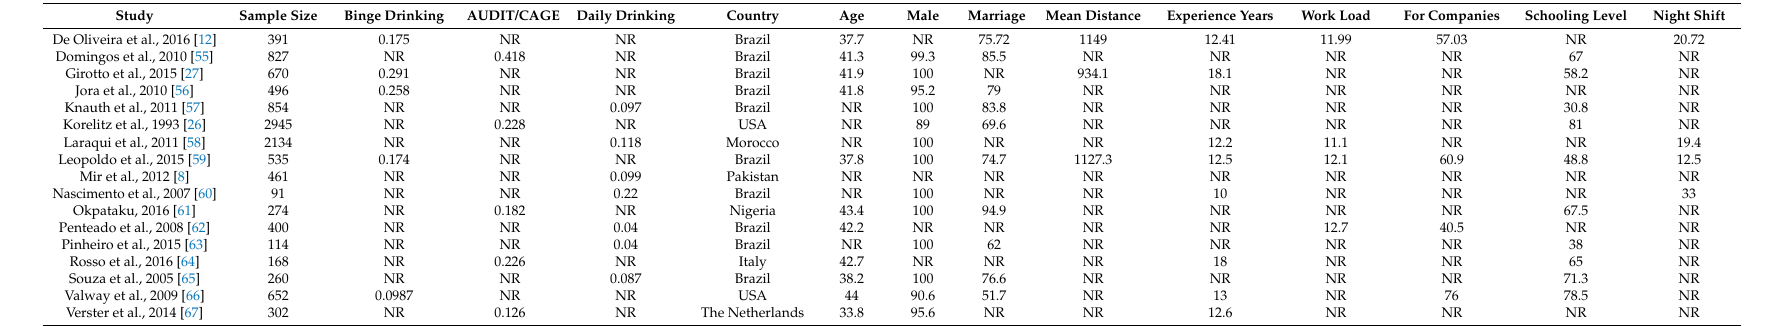
Table 4. Characteristics of the studies included in the current meta-analysis.